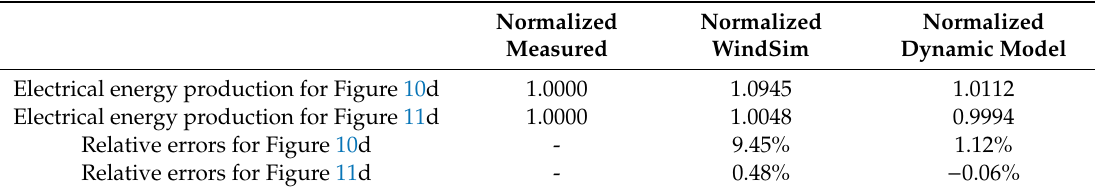
Normalized Normalized Normalized Measured WindSim Dynamic Model